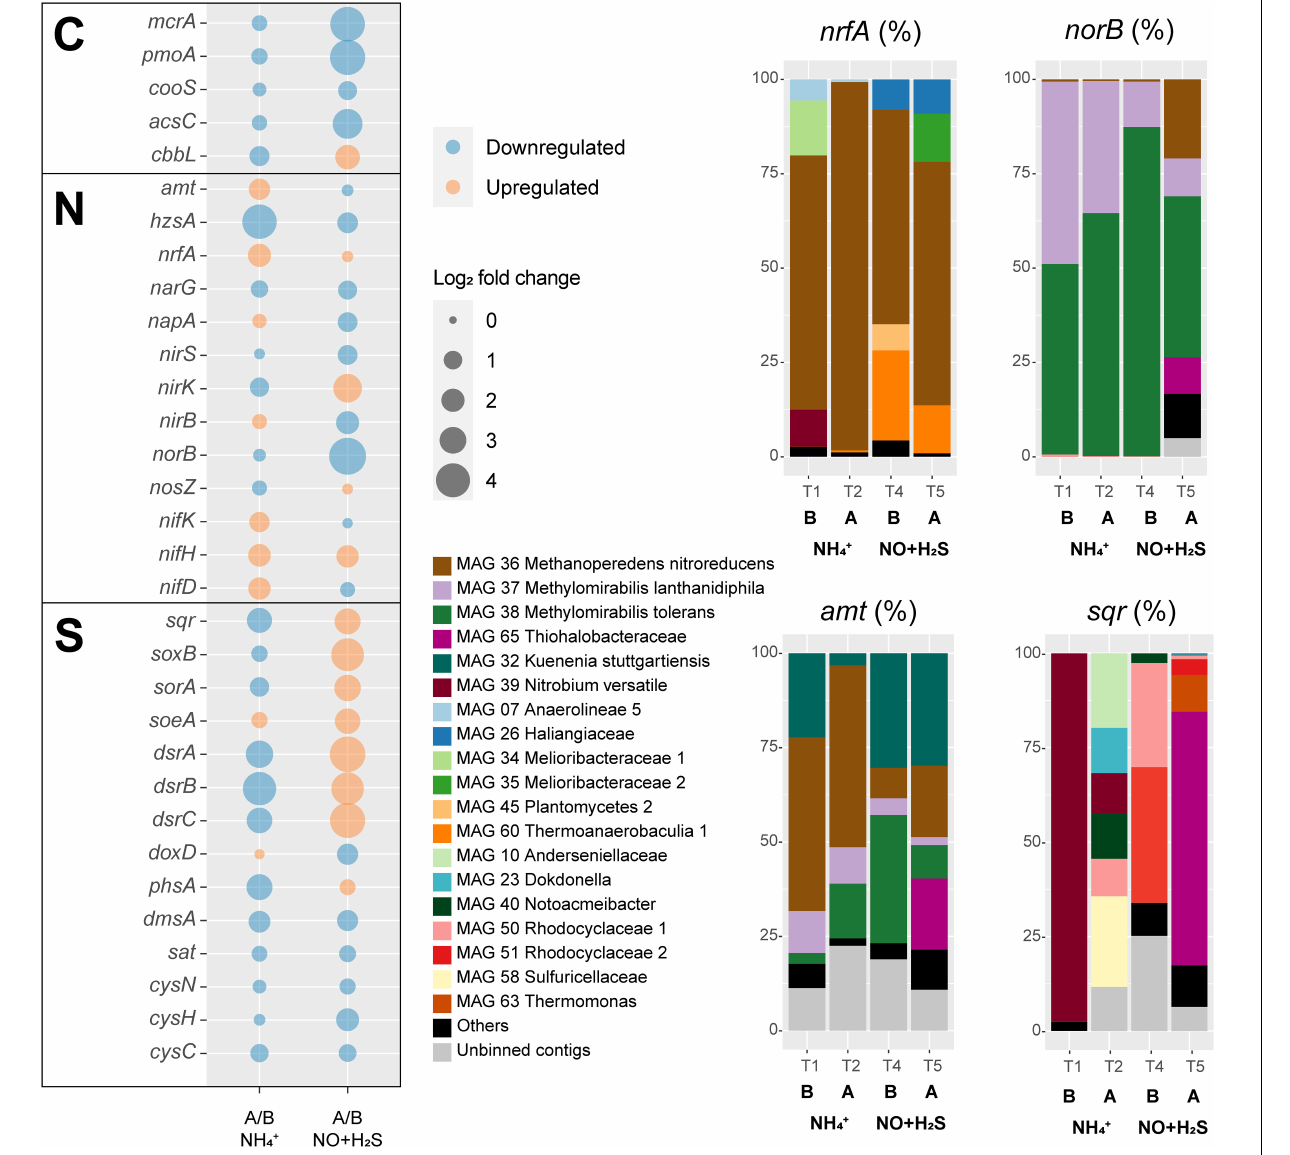
results suggest strong microbial cooperation between